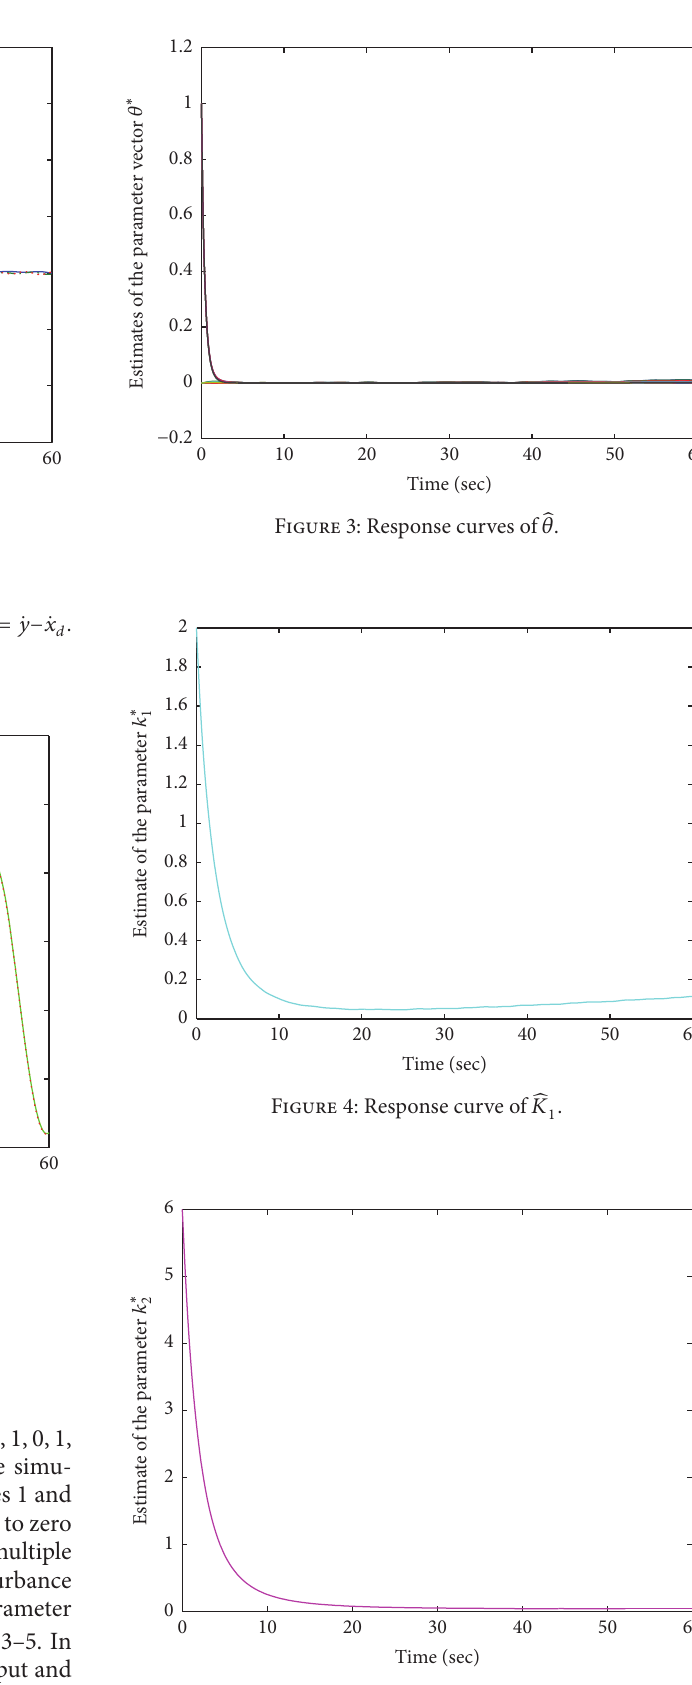
Figure 5: Response curve of